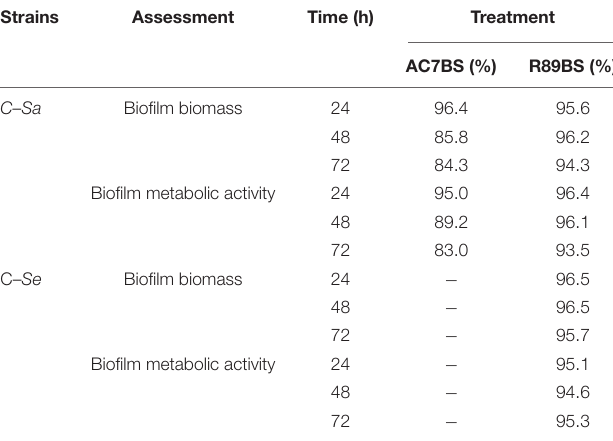
TABLE 1 | Inhibition percentages of dual-species C. albicans – S. aureus and C. albicans – S. epidermidis biofilm formation on polystyrene in co-incubation assays. The anti-biofilm activity of BSs in soluble form was detected by CV (biofilm biomass) and MTT assays (biofilm metabolic activity).